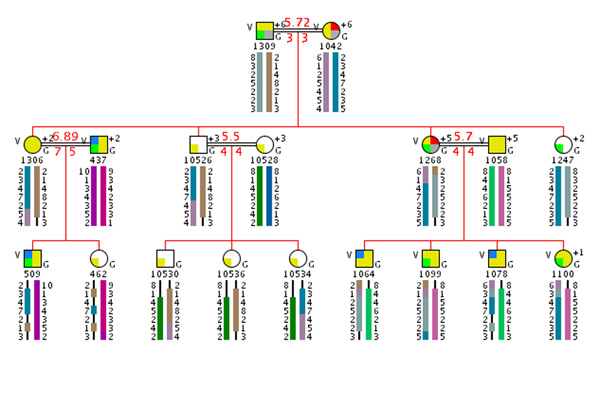
PedNavigator main page example Symbols with colored slices are affected persons, yellow slices show non-affected and white symbols stand for unknown status. Symbols are labeled with selected marker alleles. Plus signs near symbols indicate persons with expandable links. Red numbers are related with number of meiotic steps between consanguineous partners and their common ancestors (see text).